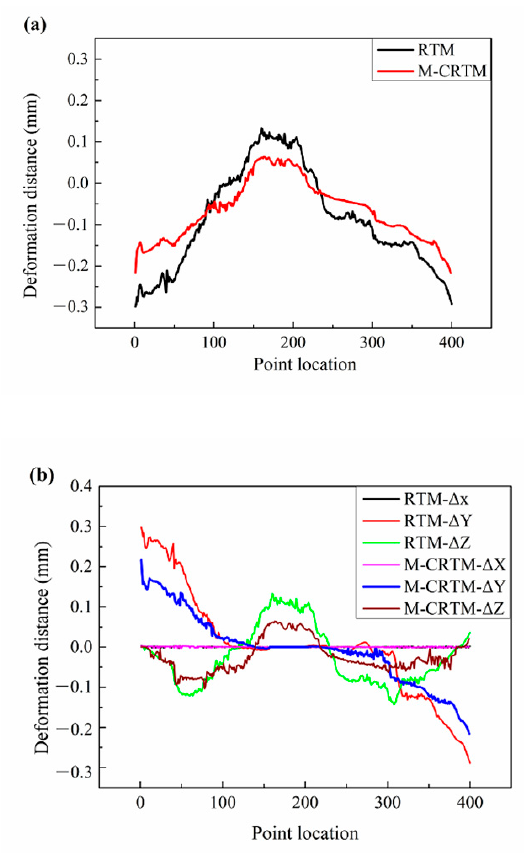
Figure 10. Deformation distance analysis of Section 1. ( a ) The total deformation distance of Section 1; ( b ) the deformation distance of Section 1 in X, Y, and Z directions. Figure 10 is the curing deformation distance diagram at different positions of Section